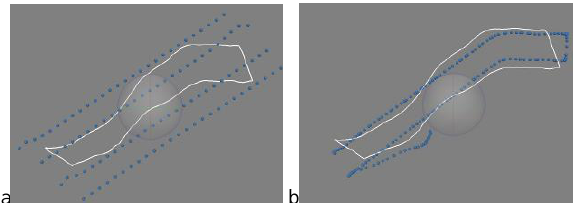
Figure 4. Details of the initial camera positions for the different setups (a) fixed-wing, (b) multi-rotor. Note the study area (white